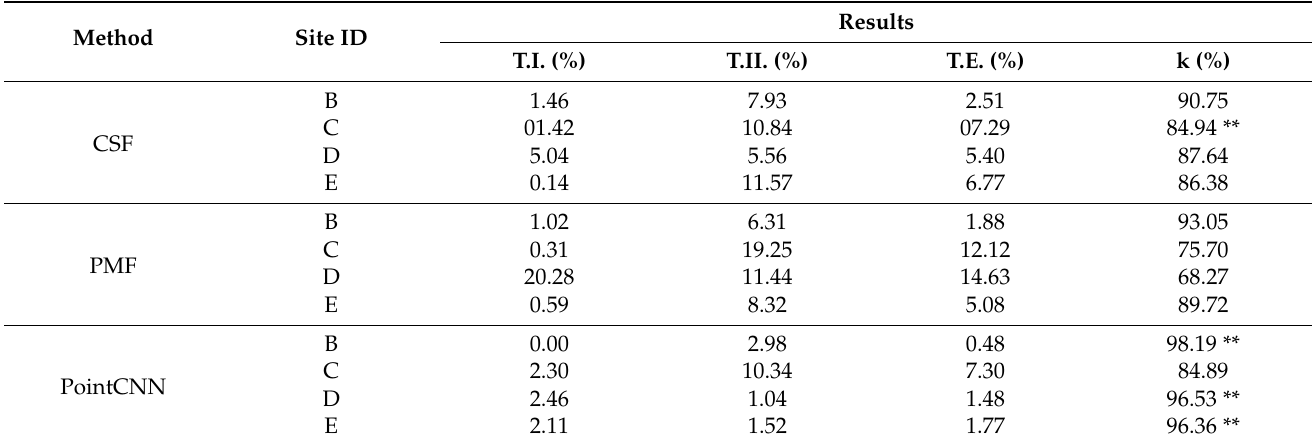
Figure 11. Comparative graph plot of error metrics of T.I., T.II., and T.E. with kappa coefficients (k) of CSF, PMF, and PointCNN for training Sites A, and test sites B, C, D, and E. Table 7. Transferability evaluation of CSF, PMF, and PointCNN for test sites with error metrics and kappa coefficients.